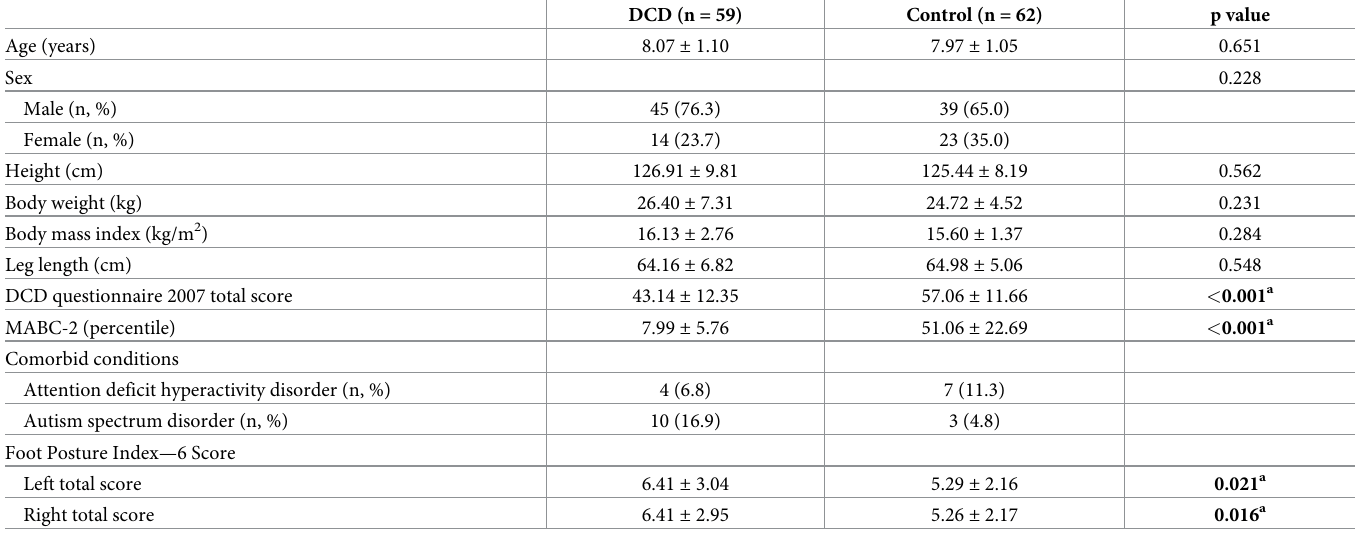
Table 1. Characteristics of the